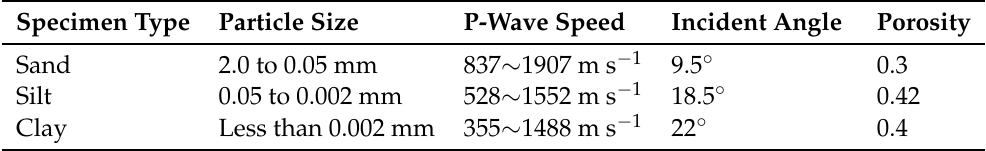
Figure 3. Test set-up. ( a ) Air-coupled ultrasonic receiver (left) and transducer (right). ( b ) Schematic diagram of the test set-up including the dimensions of specimens and distances between sensors, barrier, and soils. Table 1. Specimen type and experimental